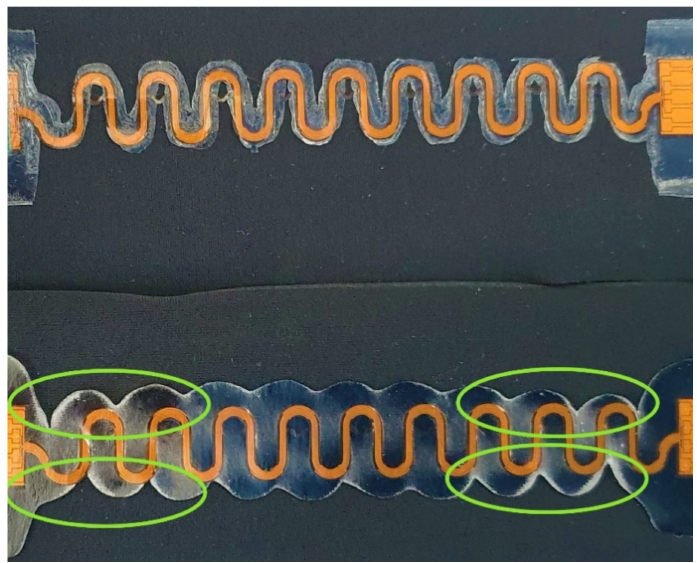
Figure 4. Melting area difference of different versions. Up: Version 1 after lamination and tensile tests. Down: Version 4 after lamination and tensile tests. Circled areas indicate higher stress areas where TPU delaminated from the edges and/or the copper-polyimide meanders broke.